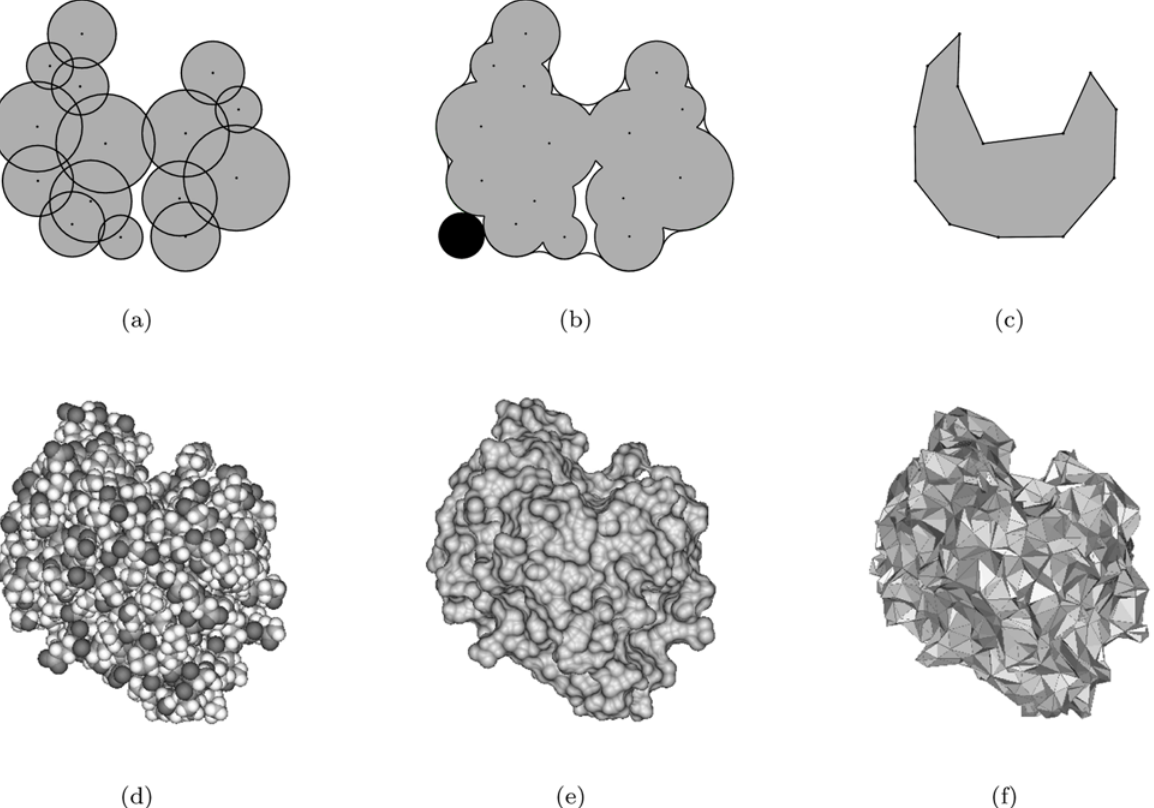
Fig 1. A schematic diagram of a molecule and its beta-shape. Figure drawn by using the BetaConcept [44] and BetaMol program freely available from VDRC. (a) A two-dimensional molecule, (b) A two-dimensional molecule and its Connolly surface corresponding to the red circular probe, and (c) the beta-shape corresponding to the probe, (d) the van der Waals model of a protein (PDB id 1oq5), (e) the Connolly surface for water molecule (with 1.4 Å radius), and (f) the corresponding